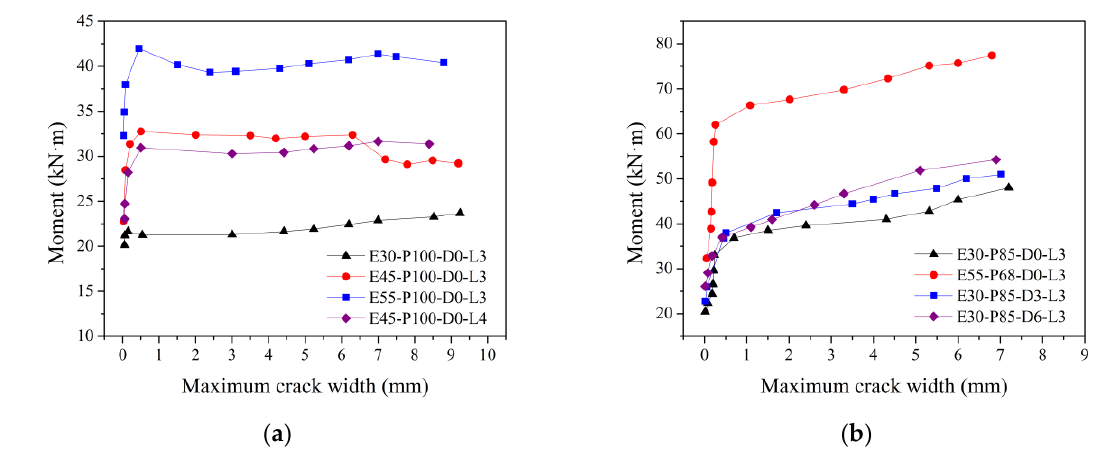
Figure 9. Moment – maximum crack width relationships of beams: ( a ) fully prestressed specimens; ( b ) partially prestressed beams.